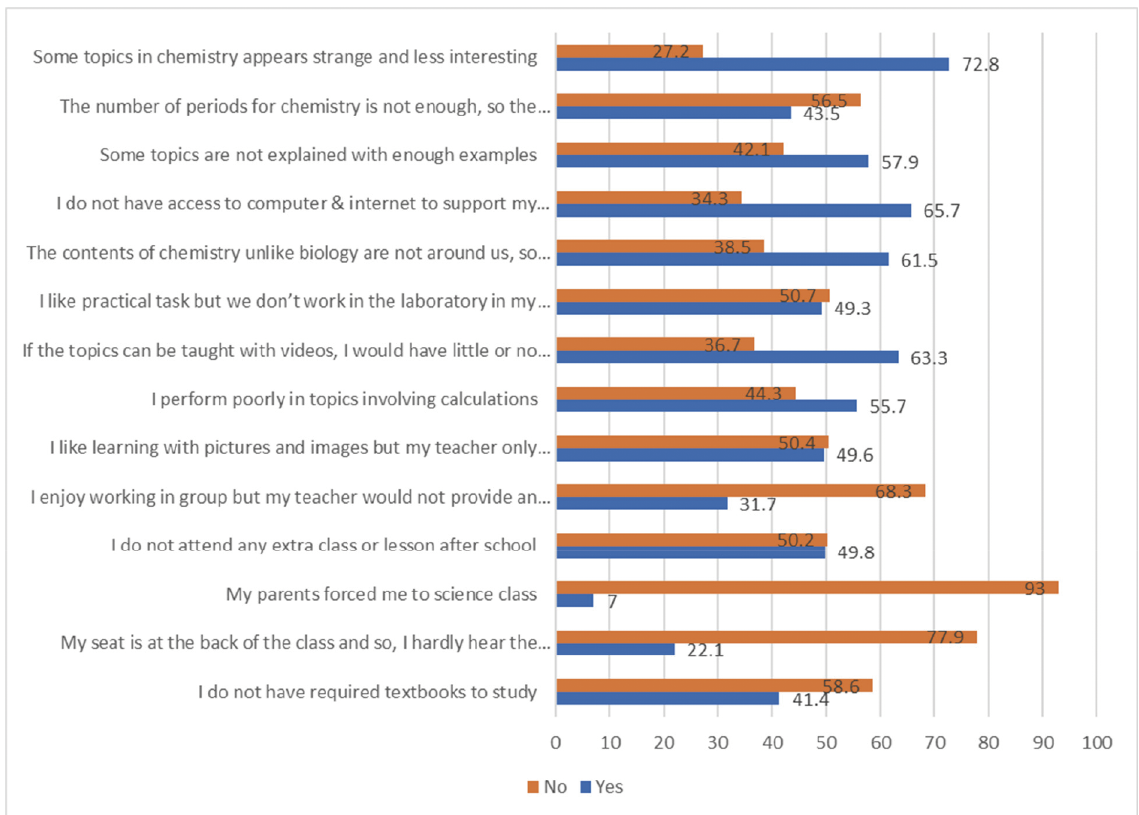
Figure 1. Reasons for perceived difficulty in chemistry